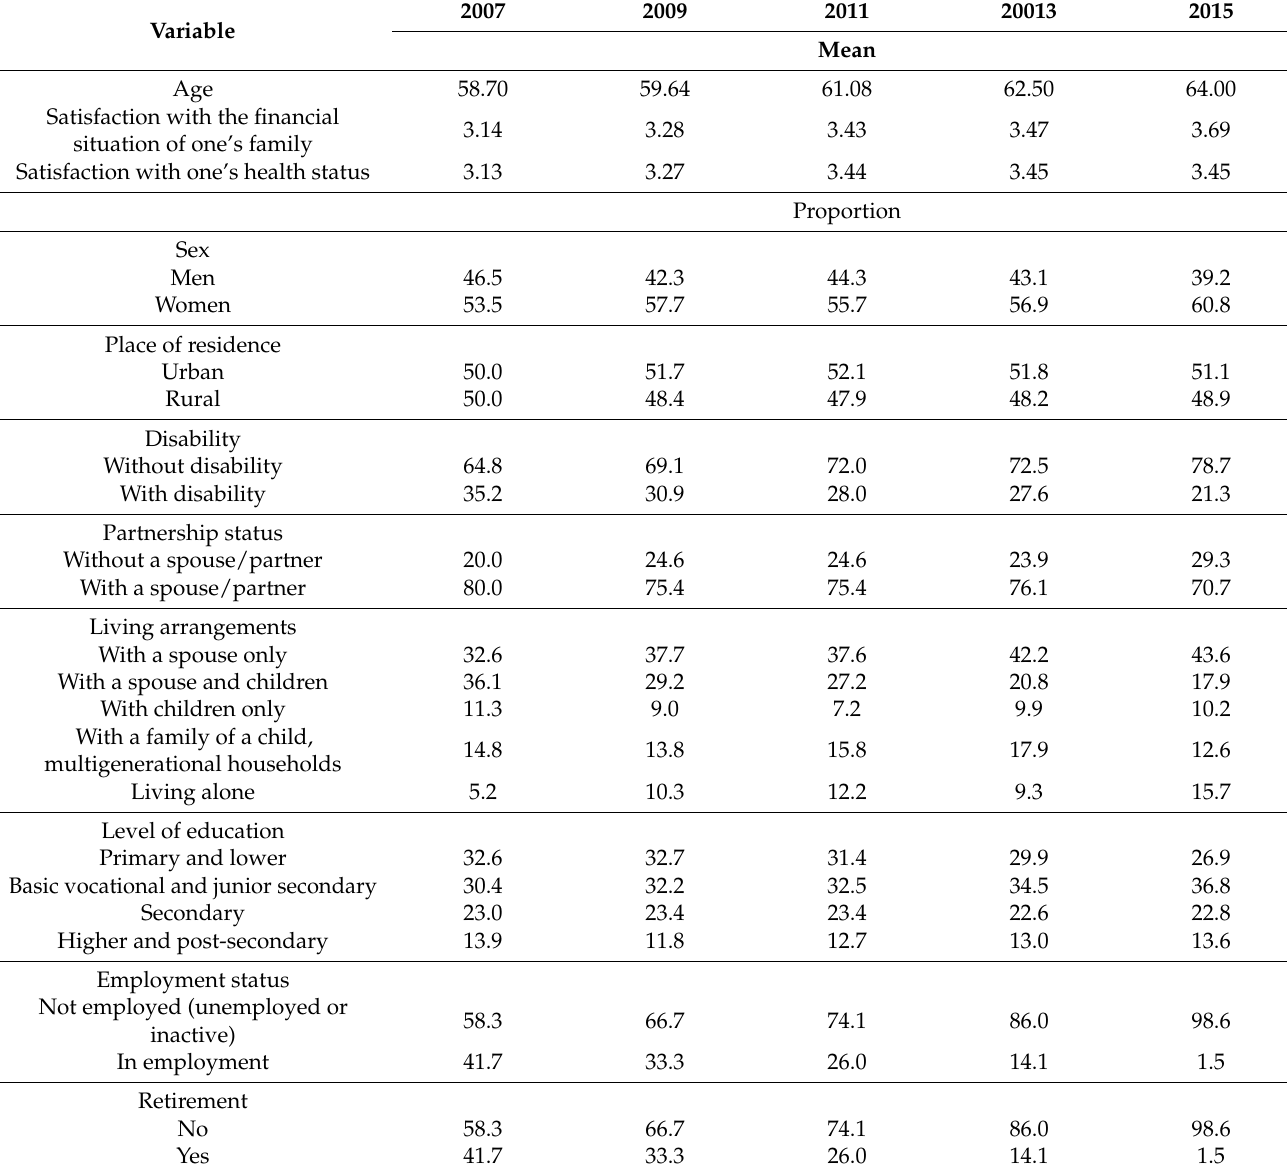
Table A1. Descriptive statistics for the control and explanatory variables for the final